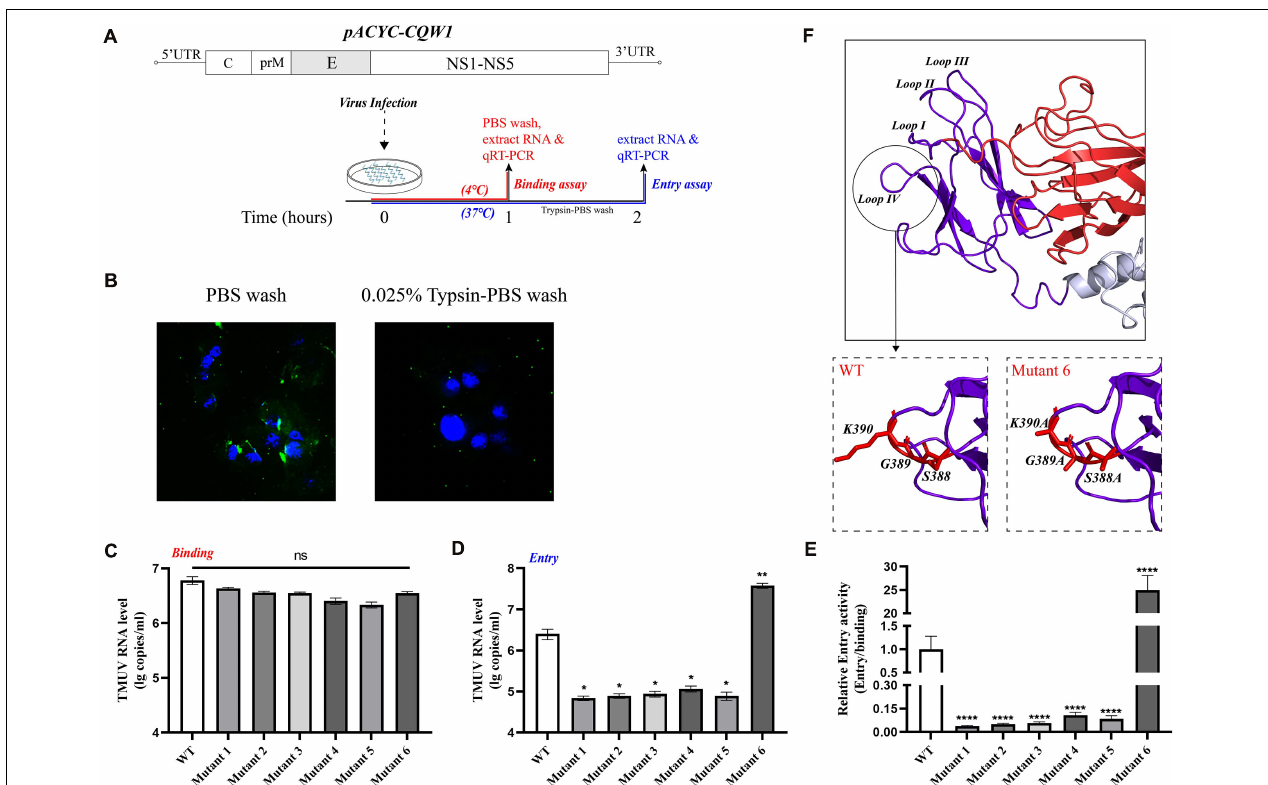
FIGURE 6 | Binding and entry activity of mutant viruses. BHK-21 cells were incubated with equal amounts of wild-type (WT) or mutant viruses. (A) Schematic diagram for the binding and entry assay. (B) Here, 0.025% trypsin-Phosphate Buffer Solution (PBS) can effectively clear the virus particles on the cell surface. Green, Tembusu virus (TMUV); blue, nucleus. (C) For attachment assay, viruses and cells were incubated for 1 h at 4 ◦ C, and the unbound viruses were removed by washing with PBS three times. The binding viral RNA of each mutant and WT was analyzed by qPCR. (D) For entry assay, virus and cells were incubated for 1 h at 37 ◦ C, and the cells were washed with 0.025% trypsin-PBS, then the cells were incubated at 37 ◦ C for an additional hour for the full entry of viral particles. The viral RNA of each mutant and WT was analyzed by qPCR. (E) The relative entry activity of each mutant was measured by the ratio of entry viral RNA to bound viral RNA. (F) Upper panel: Enlargement of the domain III, the loop regions are marked Loops I–IV ; lower panels: the S388A.G389A.K390A mutation caused the predicted lateral ridge conformation to become smoother. Means and standard errors are from three independent experiments. Asterisks denote a statistically significant difference compared to the WT. * p ≤ 0.05; ** p ≤ 0.005; *** p ≤ 0.001; **** p ≤ 0.0001.